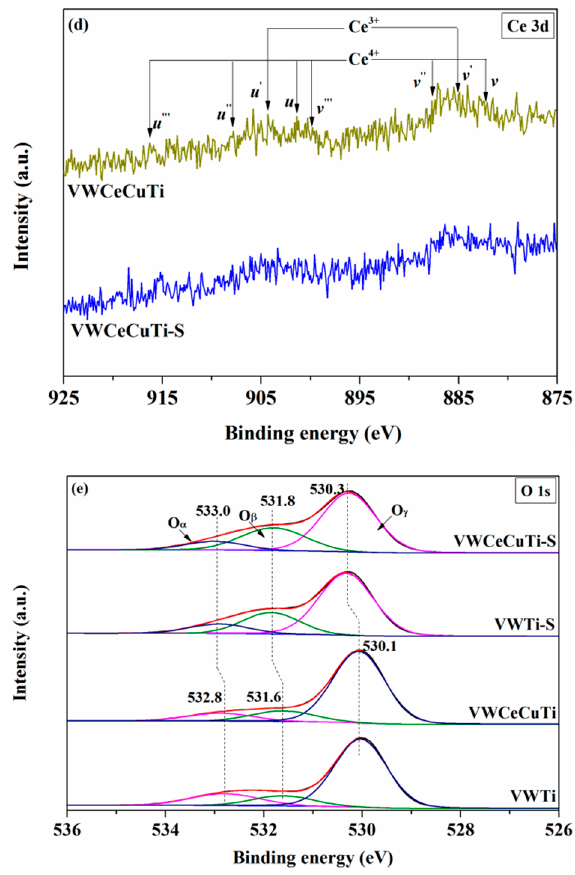
Figure 4. XPS spectra of ( a ) Ti 2p, ( b ) S 2p, ( c ) V 2p, ( d ) Ce 3d and ( e ) O 1s. Table 3. Surface atomic ratio and concentration from XPS.